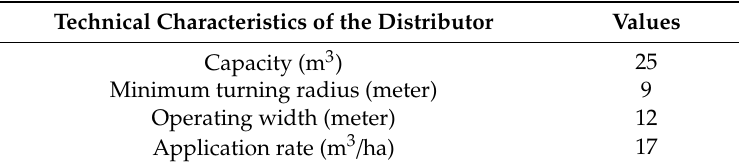
Figure 6. ( a ) Field representation for all the scenarios and ( b ) field partitioning. The arrow shows the order of track Id in the sample field. Table 5. Technical characteristics of the applied manure distributor.